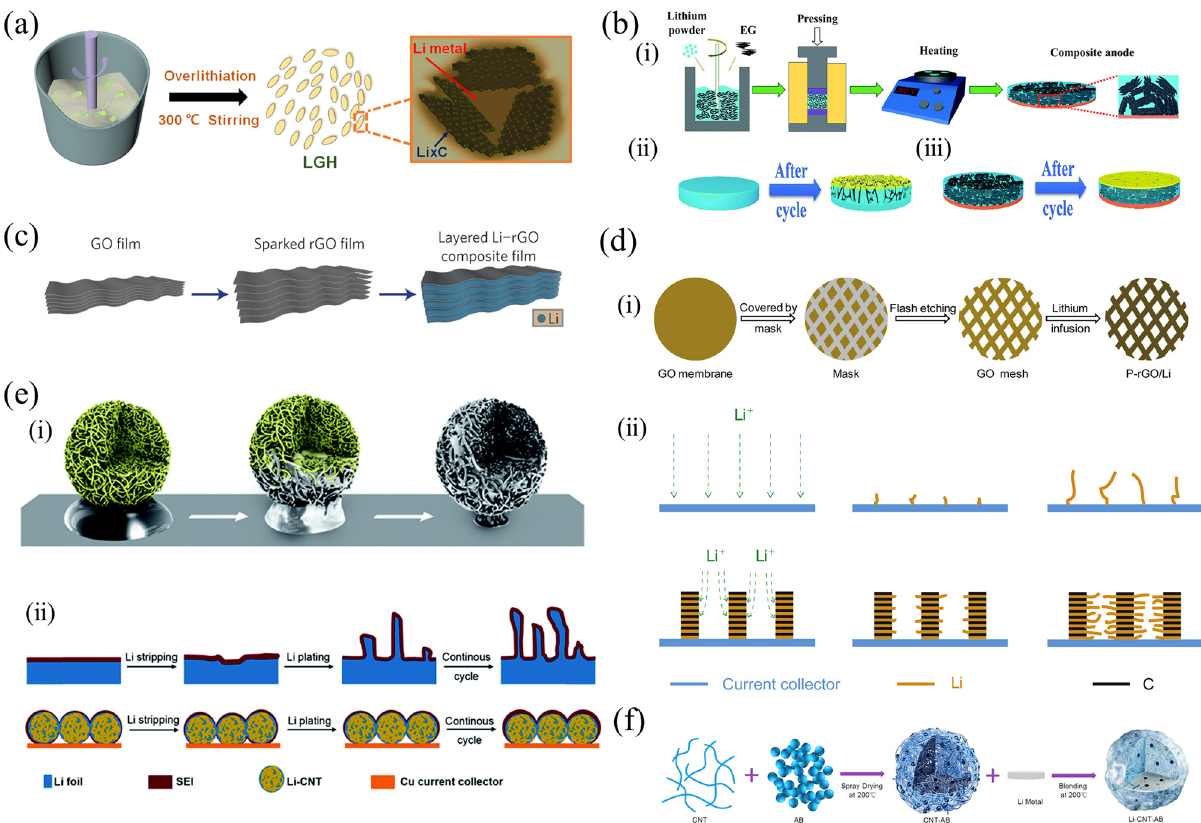
Figure 4: Schematic diagrams of ( a ) the fabrication process of LGH by the stirring molten method, reprinted with permission from ref. [ 47 ] ; ( b ) the Li – EG composite anode fabrication process ( i ) and the Li plating behavior of the Li foil ( ii ) and the Li – EG anode ( iii ) , reprinted with permission from ref. [ 48 ] ; ( c ) the material design and the consequent synthetic procedures from a GO fi lm ( left ) to a sparked rGO fi lm ( middle ) to a layered Li – rGO composite fi lm ( right ) , reprinted with permission from [ 45 ] ; ( d ) the preparation process of P - rGO/Li ( i ) and lithium deposition on planar current collectors and P - rGO/Li electrodes ( ii ) , reprinted with permission from ref. [ 49 ] ; ( e ) the molten impregnation preparation of the Li – CNT composite ( i ) and the morphological evolution during the stripping/plating cycles on Li foil and Li – CNT electrodes ( ii ) , reprinted with permission from ref. [ 51 ] ; ( f ) the synthetic procedures of the Li – CNT – AB, reprinted with permission from ref. [ 52 ]